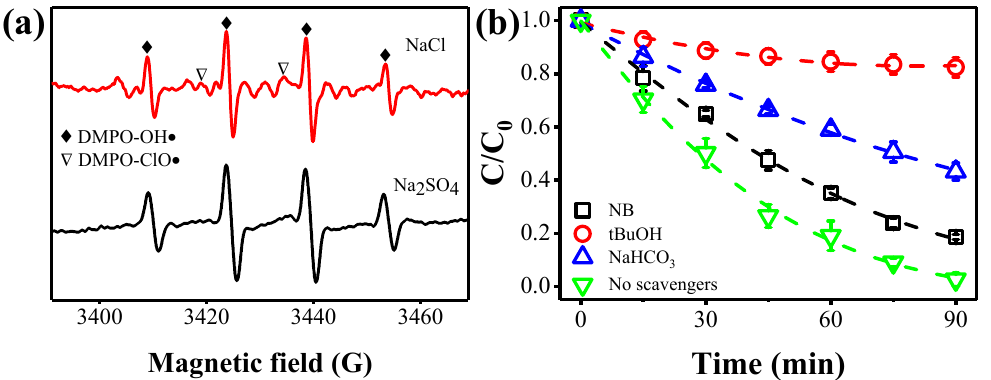
Figure 2. ( a ) EPR spectra with DMPO observed from the flow-through experiment. ( b ) Effect of different scavengers on ammonia removal.